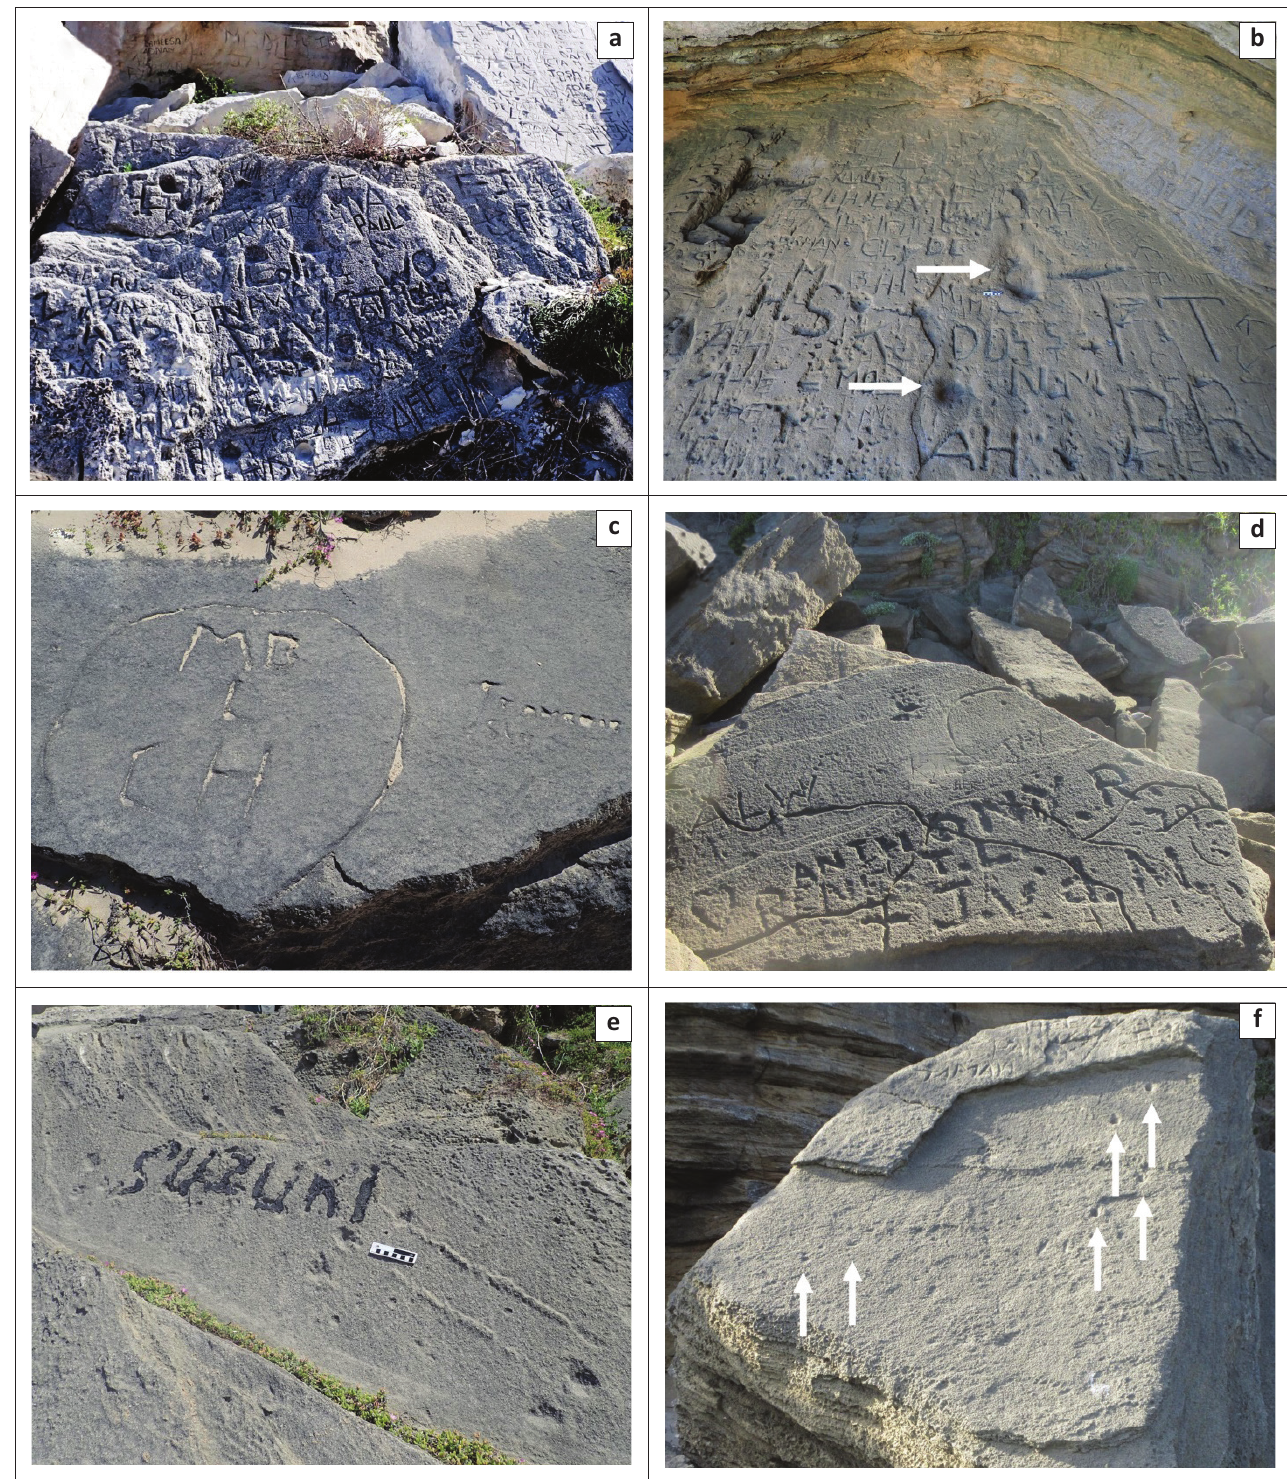
FIGURE 1: (a) Dense concentrations of graffiti on aeolianites at Kraalbaai, West Coast National Park; (b) graffiti on a cave floor surface at Brenton-on-Sea, rendering what may have been hominin tracks (two of which are indicated with arrows) undecipherable; (c) graffiti on an aeolianite surface in Goukamma Nature Reserve, metres from an important hominin tracksite; (d) graffiti on a loose aeolianite slab exhibiting well-preserved invertebrate burrow traces; (e) graffiti crossing a lagomorph trackway in Garden Route National Park; (f) bovid tracks (indicated by white arrows) exposed on a cemented foreshore deposit surface at Great Brak River following the failure of a superficial graffiti layer – vestigial areas of graffiti are evident on the overlying